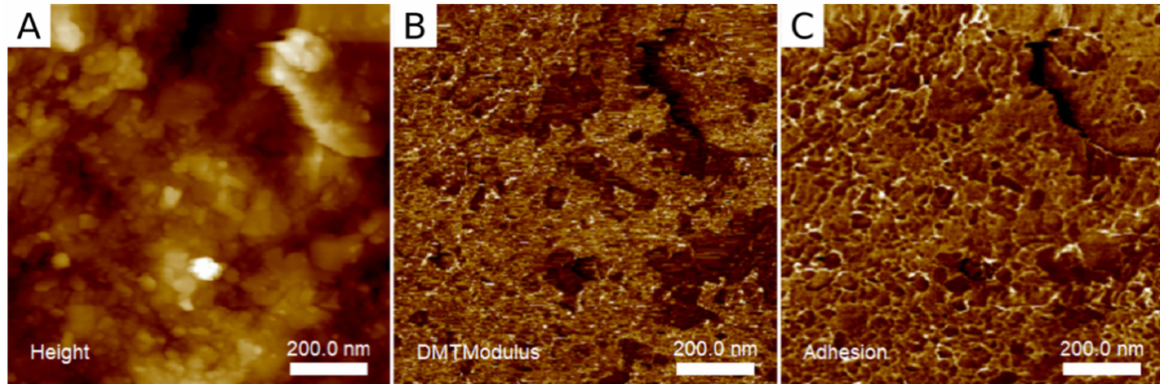
Figure 1. Visualization of topography, Mean Young’s modulus and adhesion in atomic force microscopy.